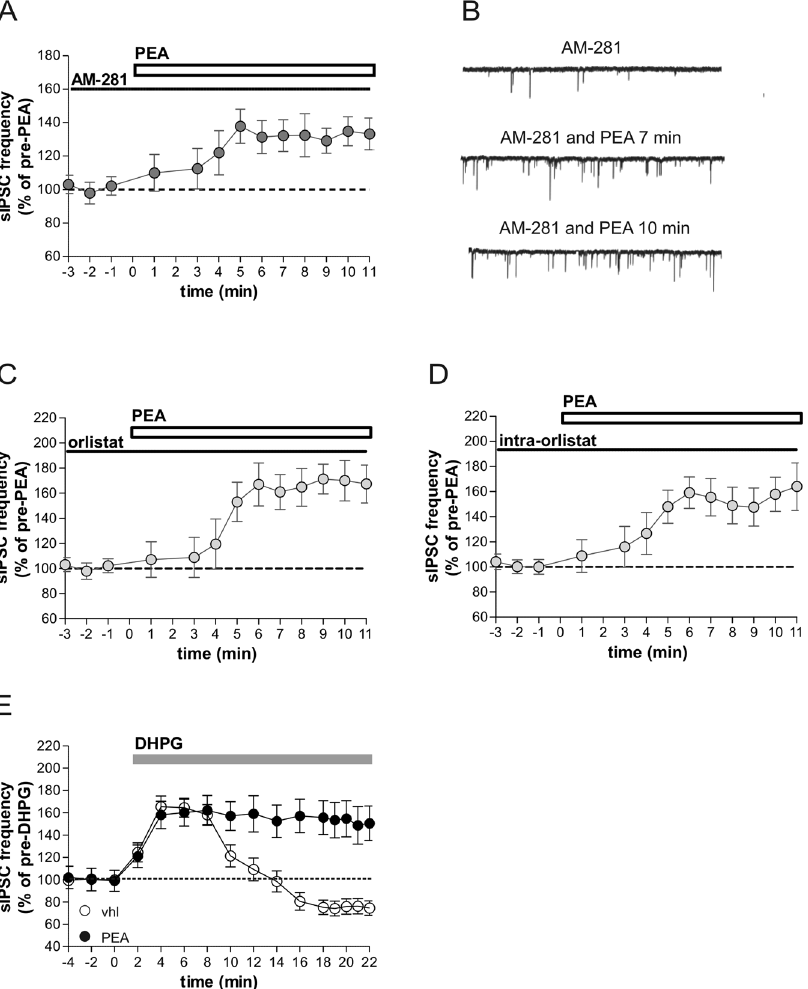
( B ) Examples of voltage-clamp recordings in the presence of AM281 before and after PEA application. ( C,D ) In these graphs it is shown that the blocker of 2AG synthesis orlistat, either when applied in the external solution ( C ) or when dissolved in the intraelectrode solution ( D ), abolished the rundown effect of PEA on sIPSCs. ( E ) Preincubation with PEA prevented the reduction of sIPSC frequency mediated by